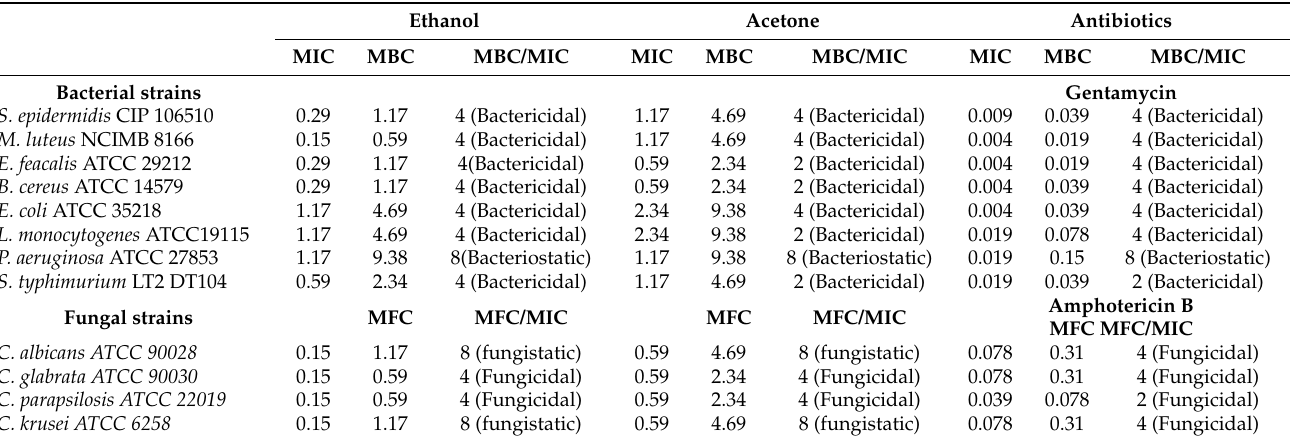
Table 6. Minimal inhibition concentration (MIC mg/mL), minimal bactericidal concentration (MBC mg/mL), minimal fungicidal concentration (MFC mg/mL), and ratios (MBC/MIC and MFC/MIC) showing quantitative antimicrobial activity of two A. indicum extracts (ethanol and acetone) against human pathogenic bacteria and fungus compared to standard antibiotics (Gentamycin and Ampho- tericin B).